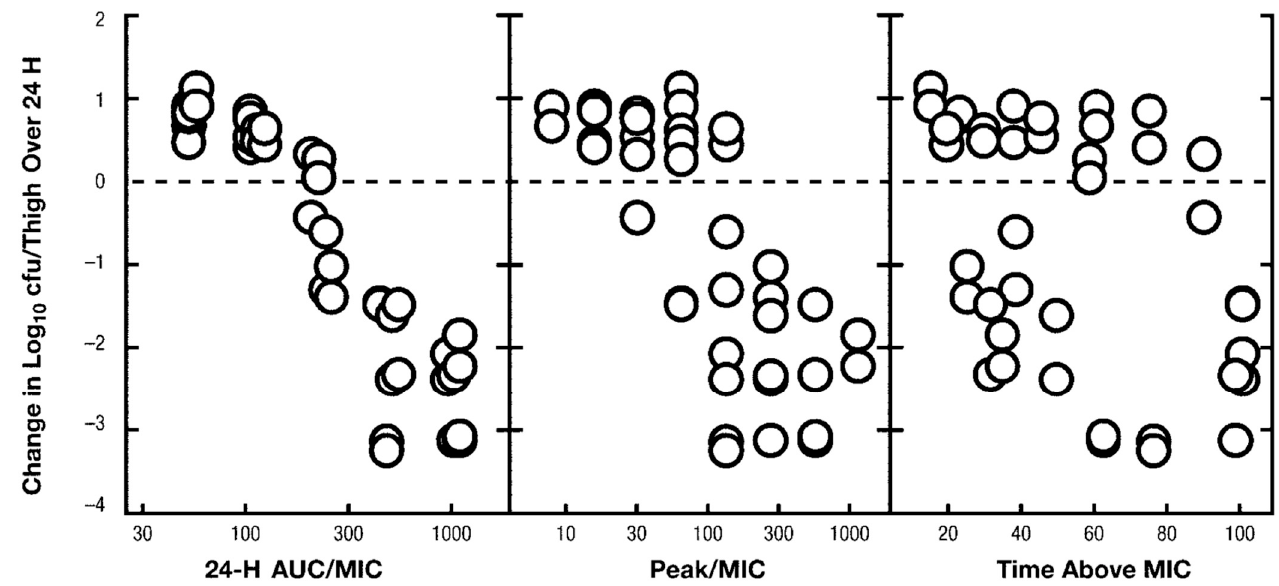
Figure 1. Depiction of the results of the methicillin sensitive Staphylococcus aureus (1 strain, MIC =1 mg/L) experiment by Ebert et al 1987 [29] from the review article by Rybak MJ, 2006 ([23], reproduced with permission). Three pharmacokinetic/pharmacodynamics indices are plotted against 24 h change in bacterial count in thighs of mice. Note the methicillin-resistant strain results were not presented nor discussed in the text of the review.